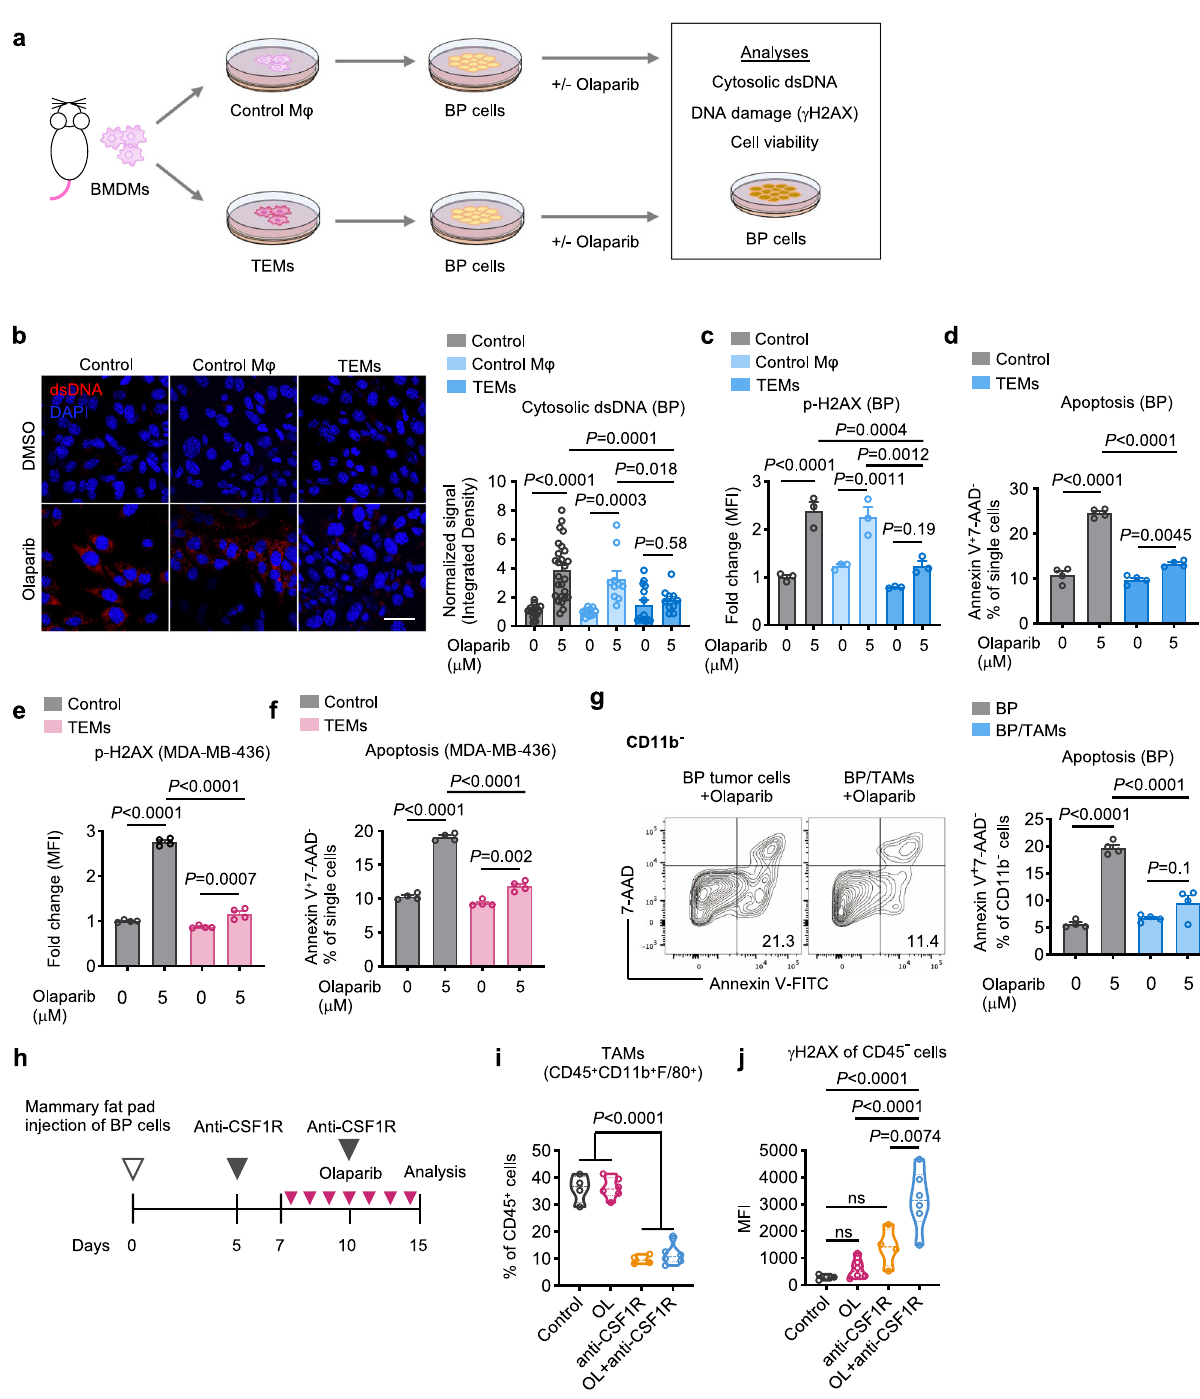
Fig. 3 TEMs/TAMs suppress olaparib-induced DNA damage in BRCA1-de fi cient breast tumor cells. a Diagram of work fl ow for ( b ) – ( f ). Conditioned media from control macrophages (M φ ) or tumor-educated macrophages (TEMs) were added to tumor cell cultures, followed by olaparib treatment. b BP cells were stained using DAPI and an anti-dsDNA antibody after two days of olaparib treatment. The intensity of dsDNA fragments in the cytosol was quanti fi ed. Scale bar, 50 μ m (control, n = 21 fi elds; olaparib, n = 26 fi elds; control macrophages, n = 10 fi elds; control macrophages + olaparib, n = 10 fi elds; TEMs, n = 14 fi elds; TEMs + olaparib, n = 10 fi elds examined over two independent experiments). c BP cells were stained with anti-H2AX phospho-Ser139 antibody and analyzed by fl ow cytometry. MFI, median fl orescence intensity ( n = 3). d BP cells were analyzed for apoptosis (Annexin V + 7-AAD − ) ( n = 4). e MDA-MB-436 cells were stained with anti-H2AX phospho-Ser139 antibody and analyzed by fl ow cytometry ( n = 4). f MDA-MB-436 cells were analyzed for apoptosis (Annexin V + 7-AAD − ) ( n = 4). g Apoptotic analyses of BP cells co-cultured with or without TAMs sorted from BP tumors, followed by three days of olaparib treatment ( n = 4). Flow cytometry plot axes are displayed in logarithmic scale. h Schematic representation of the experiments for ( i ) and ( j ). i and j Analysis of TAMs ( i ) and γ -H2AX in CD45-negative cells ( j ) in BP tumors after two IP injections of anti-CSF1R antibody and 7 days of treatment with olaparib (OL) as monotherapy or in combination. Control, n = 4; OL, n = 6; anti-CSF1R, n = 4; OL + anti-CSF1R, n = 6. Each dot represents data from a single tumor. Data are presented as mean±SEM ( b ) – ( g ) or median with quartiles (violin plots, i and j ). One-way ANOVA. ns, not signi fi cant. Source data are provided as a Source Data fi le.